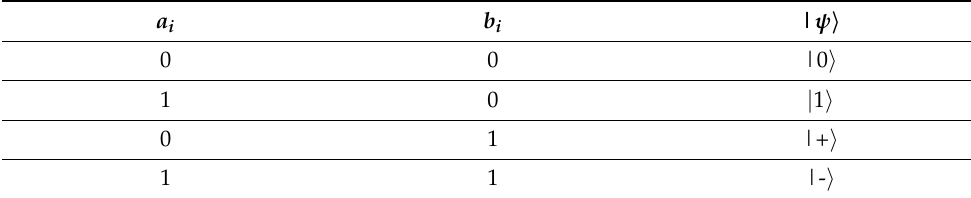
Table 4. The four possible states of a qubit in a BB84-encoded string. a i b i